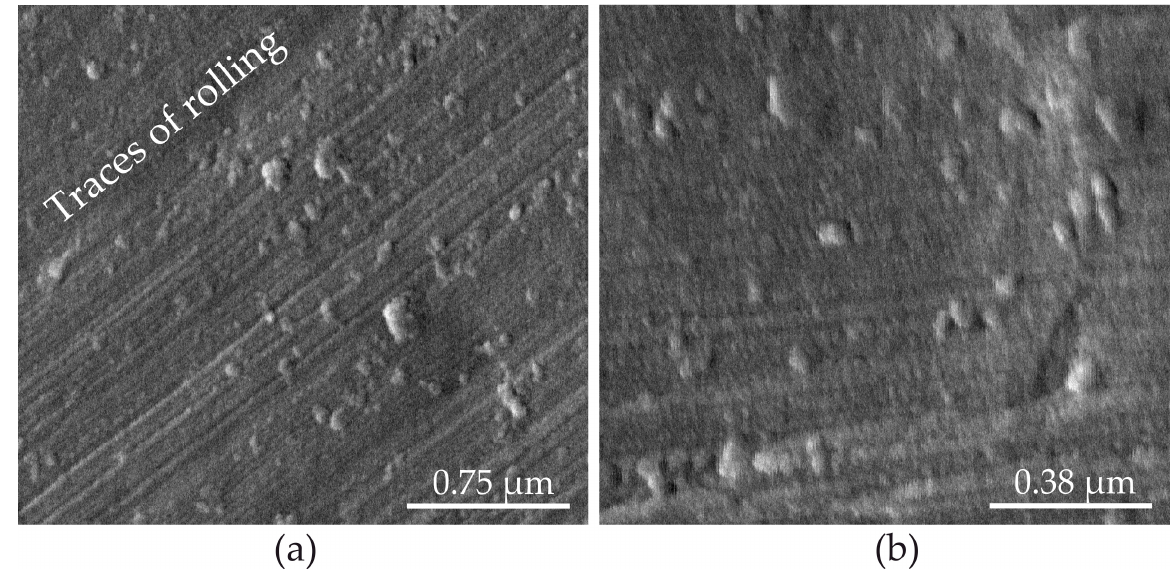
Figure 13. SEM images of the original aluminum foil surface at various resolutions: ( a ) ×40,000 and ( b ) ×80,000.